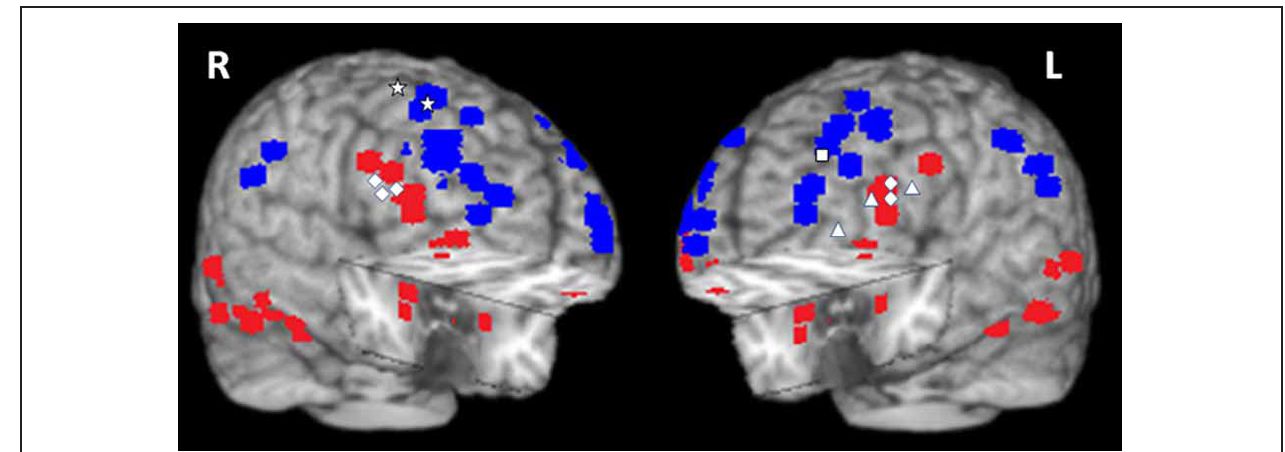
FIGURE 10 | Summary of activations in brain regions associated with the ventral HotEmo system (red) and the dorsal ColdEx system (blue). The figure shows peak activation voxels from areas showing increased (red) and decreased (blue) activity to emotional distraction, as identified by the studies featured in Table 1 . The white geometric shapes identify peak voxels from regions associated with coping with emotional distraction, in women and men. Specifically, for the female subjects, the rhombi identify peak activation voxels from bilateral inferior frontal areas controlling for the subjective “feeling of being distracted” (Dolcos and McCarthy, 2006). The triangles identify peak activation voxels